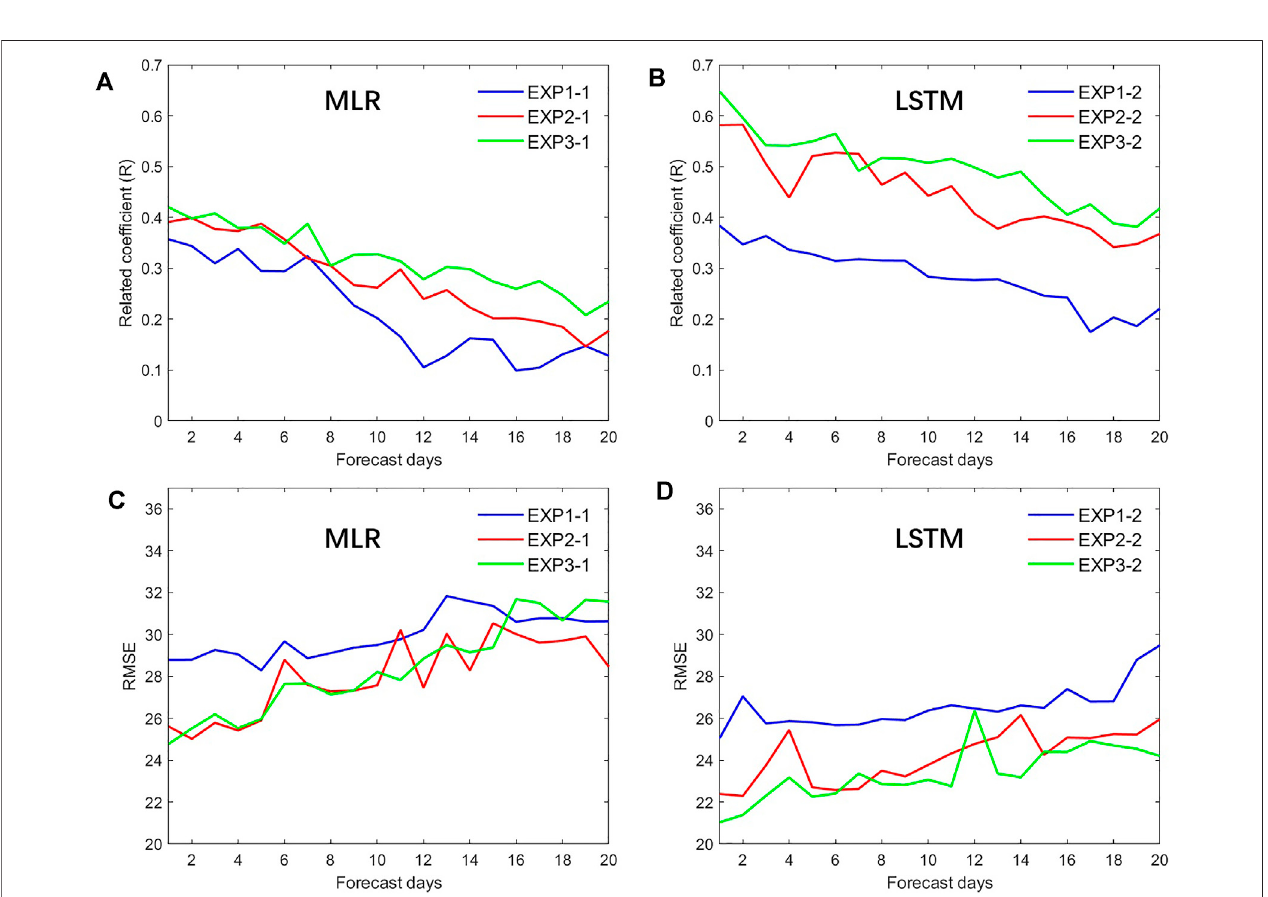
FIGURE 6 | Individual experiment forecast result veri fi cation of EXP 1 to EXP 3 (A,B) R (the 95% con fi dence level is 0.18) (C,D) RMSE.